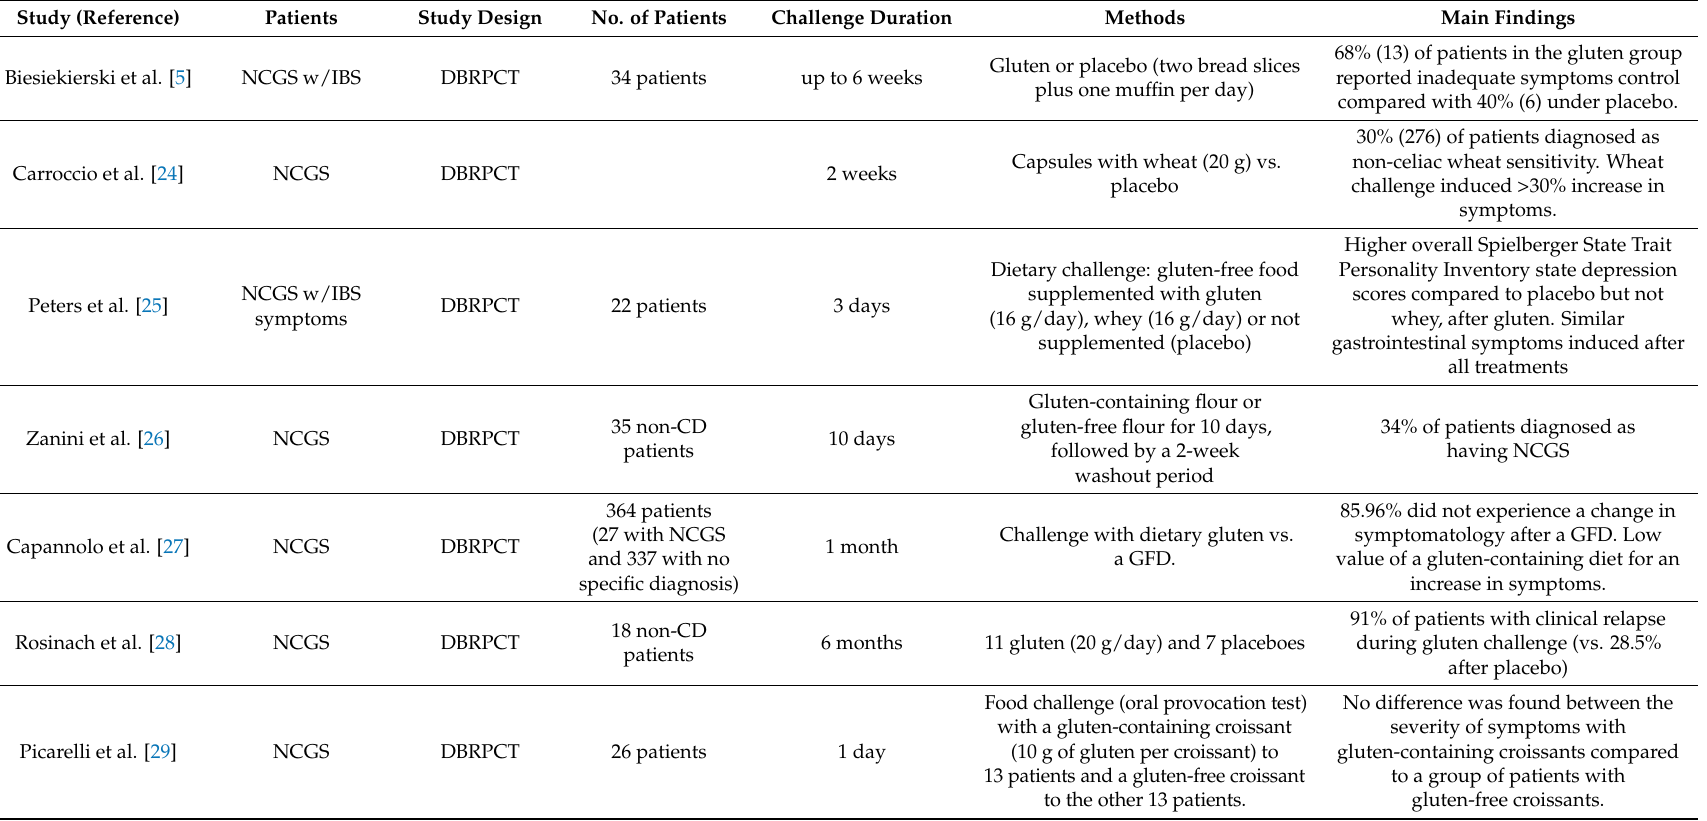
Table 1. Summary of clinical trials evaluating a gluten re-challenge in NCGS